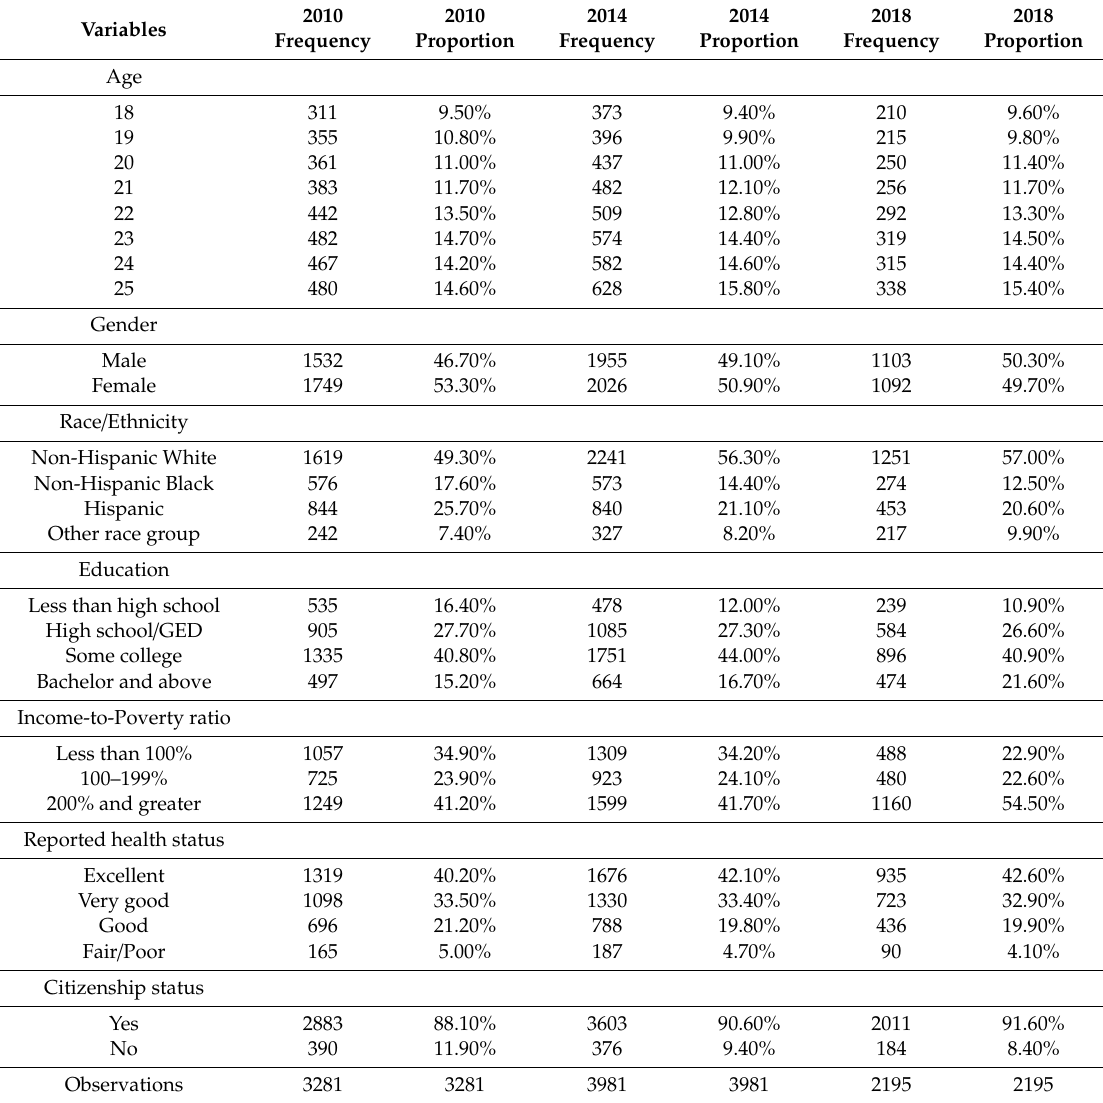
Table 1. Sociodemographic Statistics, National Health Interview Survey